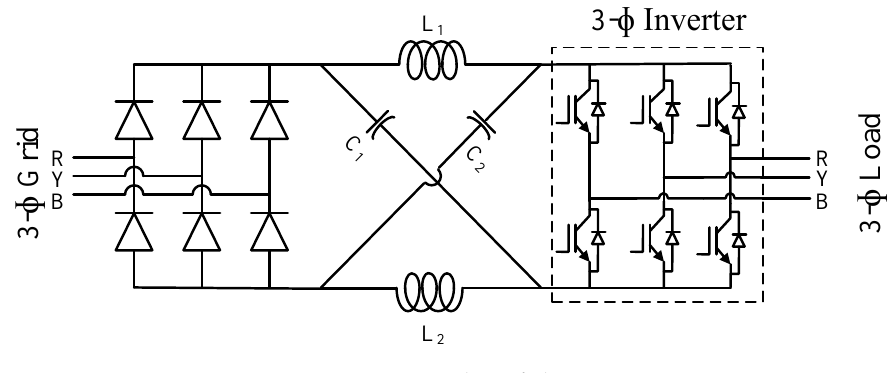
Figure 11. A voltage fed ZSI.